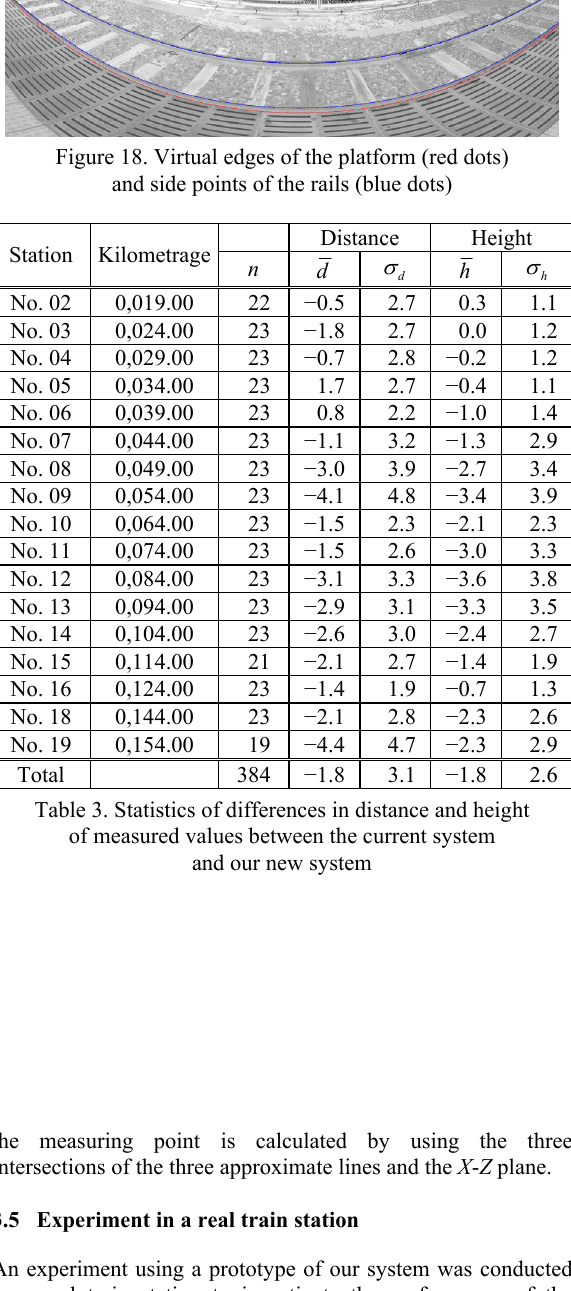
points of the far rail and the given gauges. Length of each line segment is 0.5m to 1.0m depending on the curvature of the track.